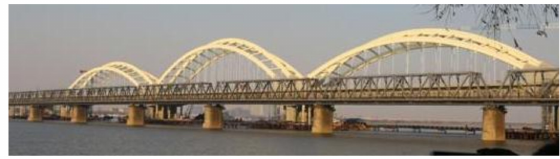
Figure 5. The view of H-Q